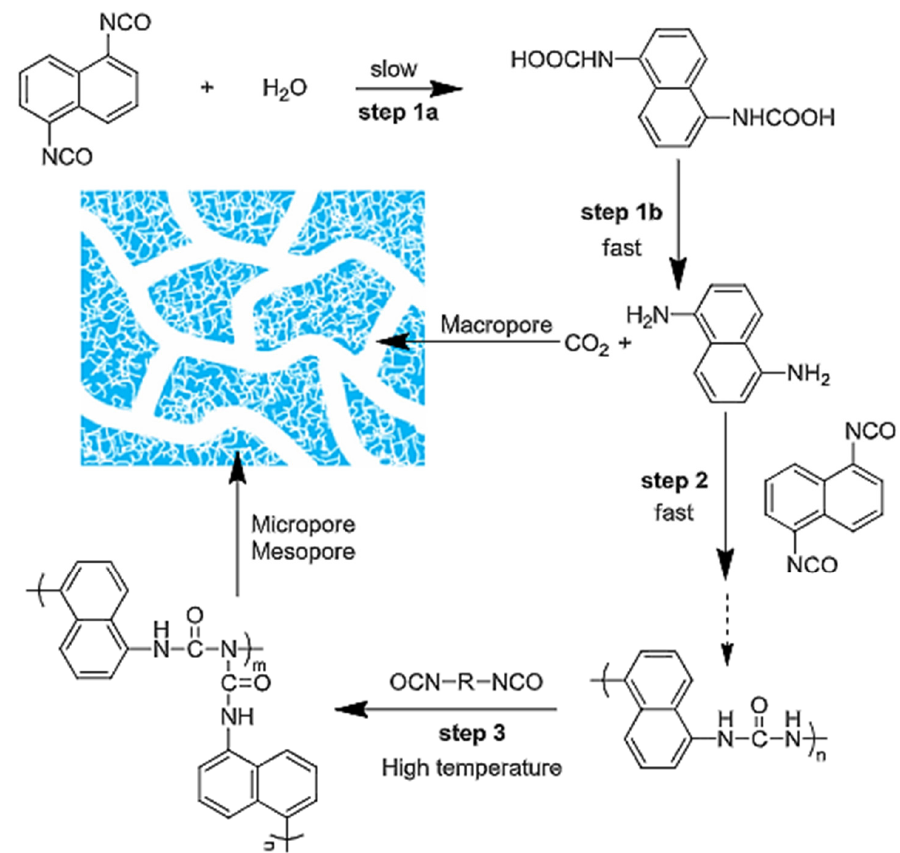
Figure 54. Schematic illustration of formation process for HPUs. From reference [87].